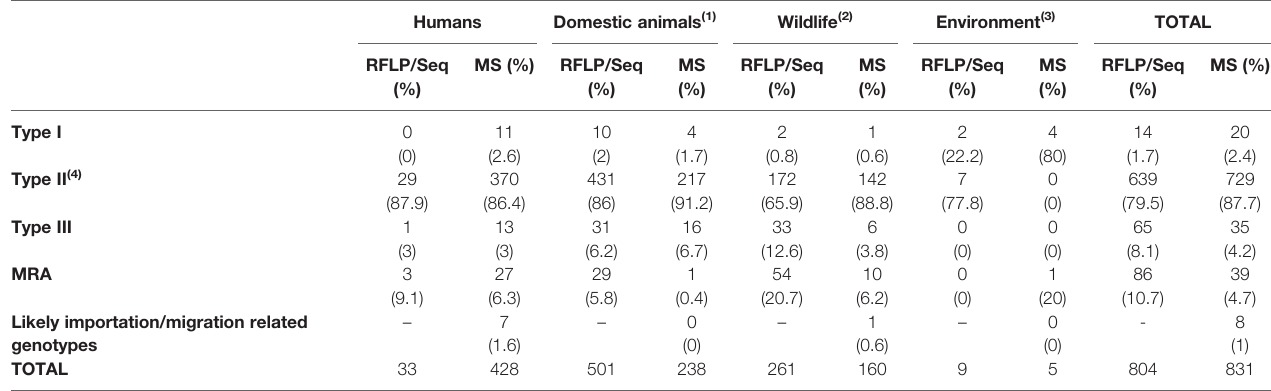
TABLE 1 | Prevalence of the Toxoplasma gondii genetic types observed in isolates and DNA positive specimens/clinical samples in Europe according to the four compartments within the One Health concept (human, domestic animals, wildlife, and environment) and based on PCR-RFLP/PCR-sequencing or MS